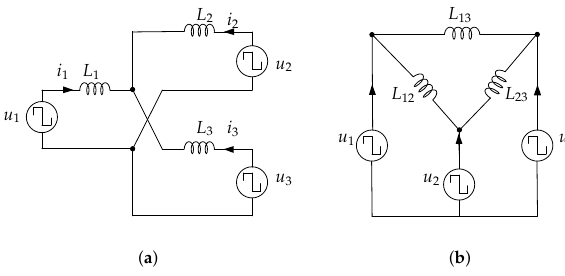
Figure 5. Equivalent circuit of the TAB converter. ( a ) Y-type, ( b ) ∆